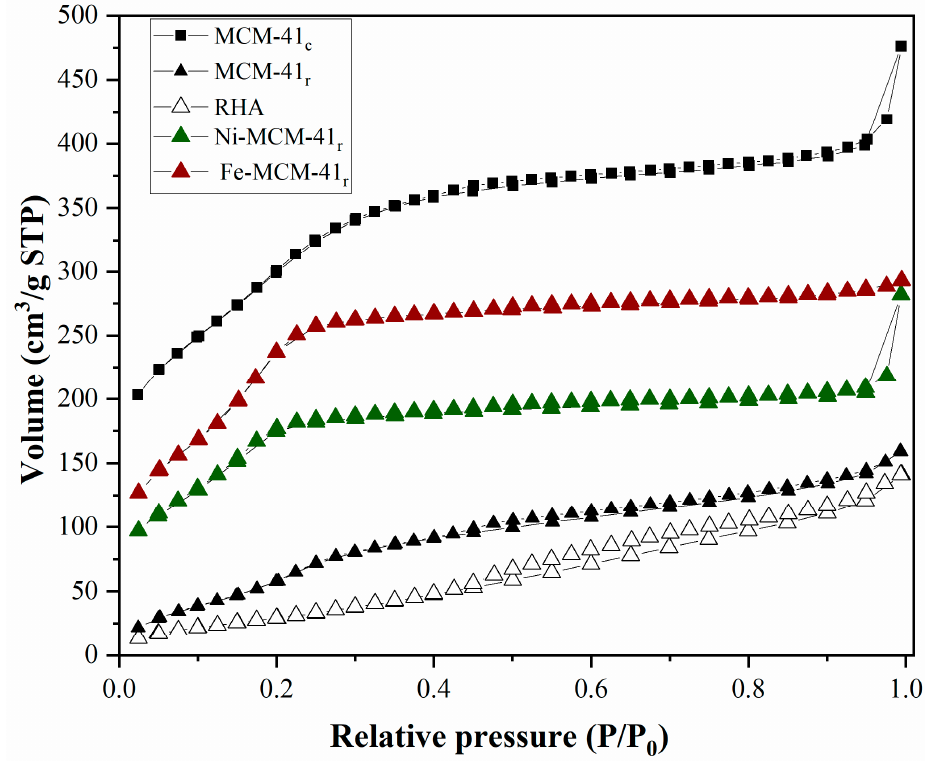
Figure 4. Adsorption–desorption isotherms and pore distribution for MCM-41 resulting from classical synthesis (MCM-41 c ) and RHA (MCM-41 r ). Table 2. Textural parameters of RHA and silica